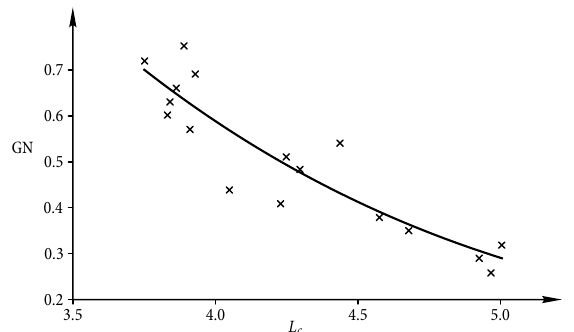
Fig. 9. GN versus L c decay after de-rubberizing